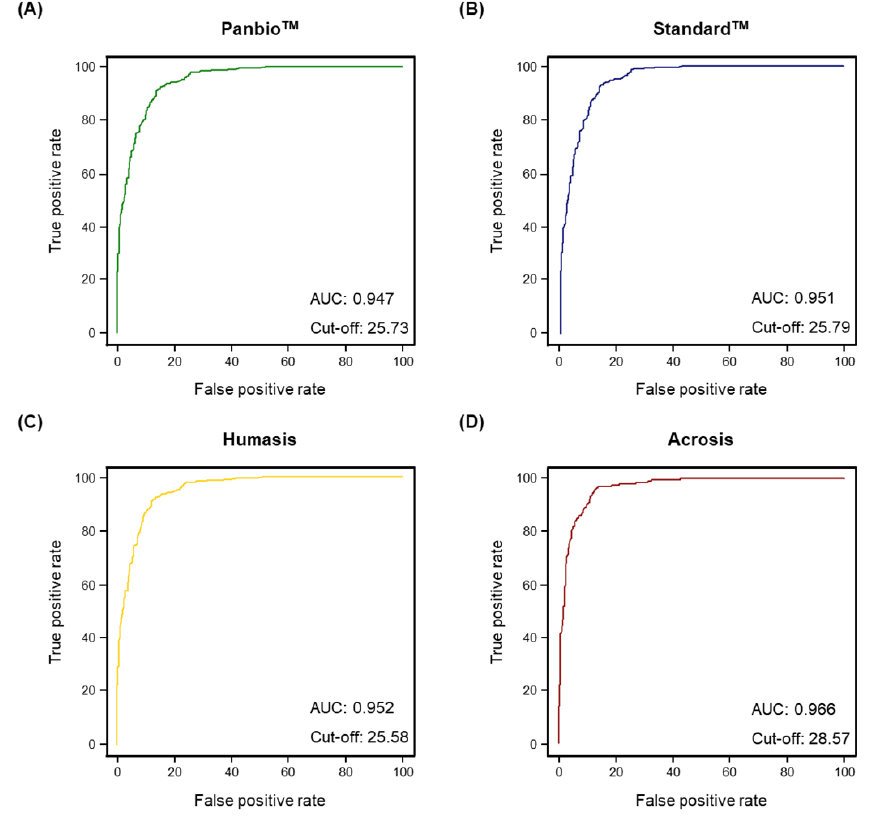
Figure 1. Performance of the four RAT kits in detecting SARS-CoV-2 (based on Ct values). ROC curves showing the diagnostic performance of the ( A ) Panbio TM , ( B ) Standard TM , ( C ) Humasis, and ( D ) Acrosis kits. The colored lines represent the diagnostic performance of each RAT